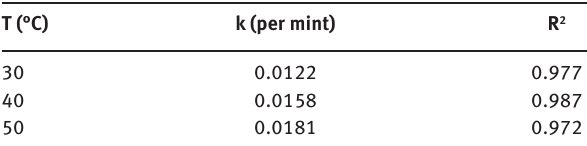
Table 2: Rate constants of Ag-Co methyl orange.